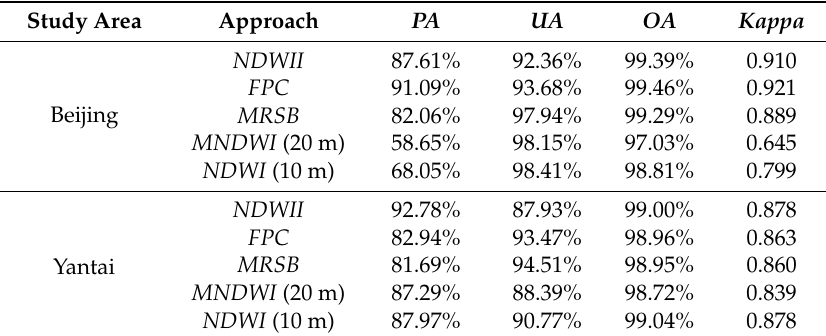
Table 2. Water mapping accuracy assessment results on the Sentinel-2 image. Study